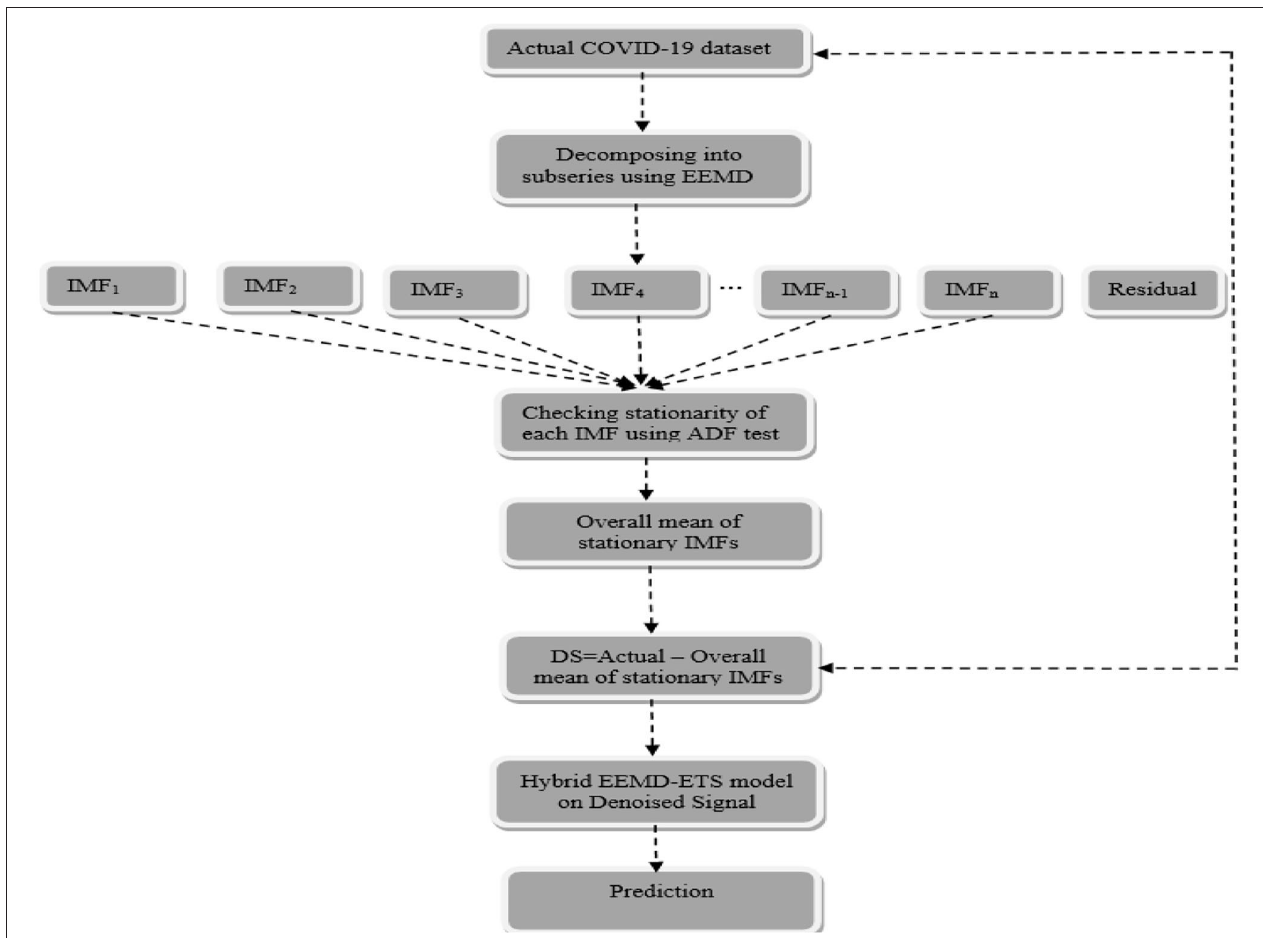
FIGURE 2 | Flowchart of the proposed hybrid EEMD-ETS model. Where “DS” means denoised